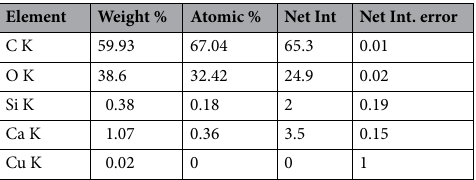
Table 2. Elemental analysis results of a modern juniper cone.